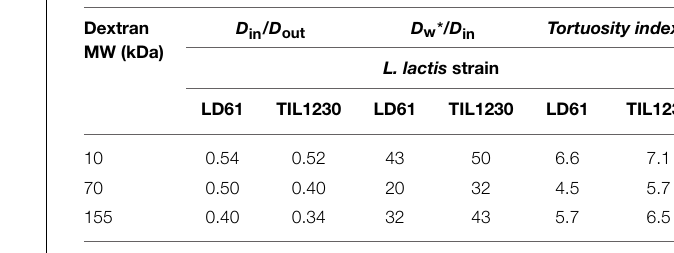
*Dw values at 20 ◦ C calculated by using the Stokes-Einstein